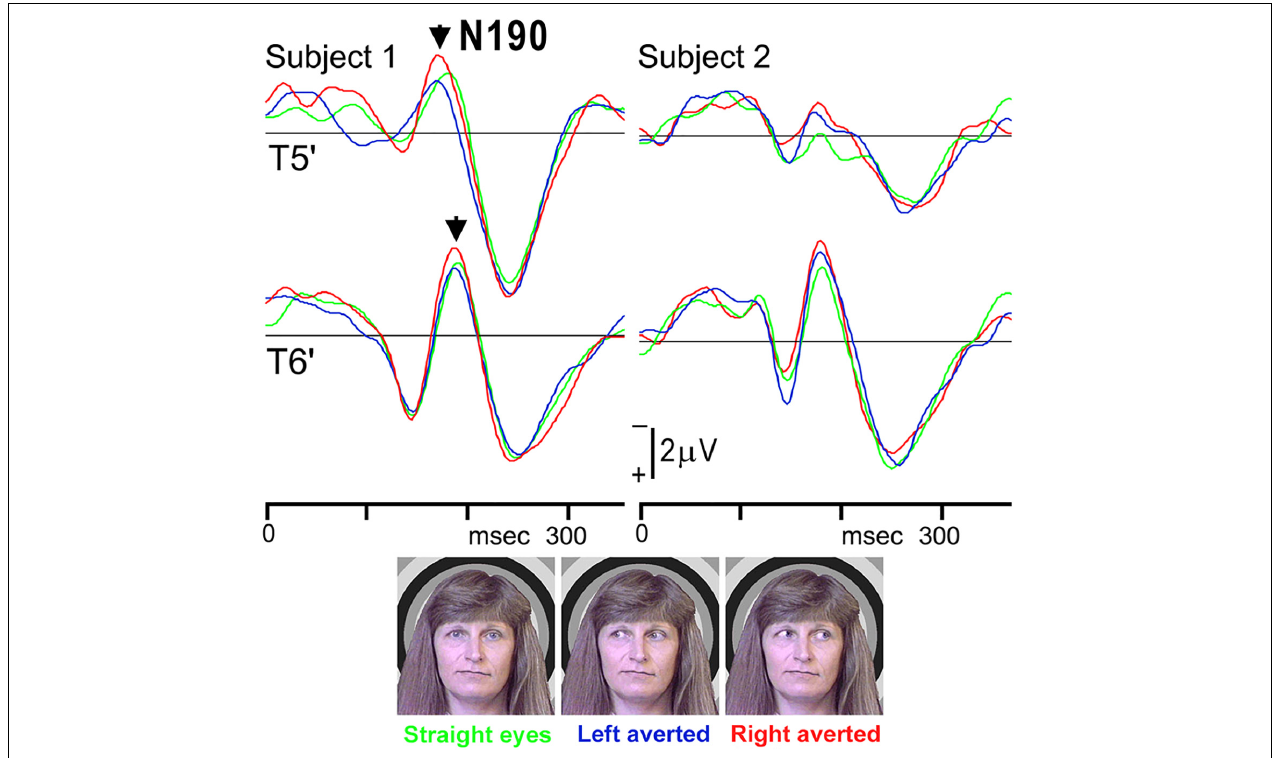
FIGURE 4 | ERP waveforms in two representative subjects for straight eyes, left averted, and right averted conditions at T5 (cid:48) and T6 (cid:48) electrodes in the left and right temporal areas, respectively. A negative component, N190, was clearly identified for all stimuli [adopted from Watanabe et al. (2002)]. ERP, event-related potentials.